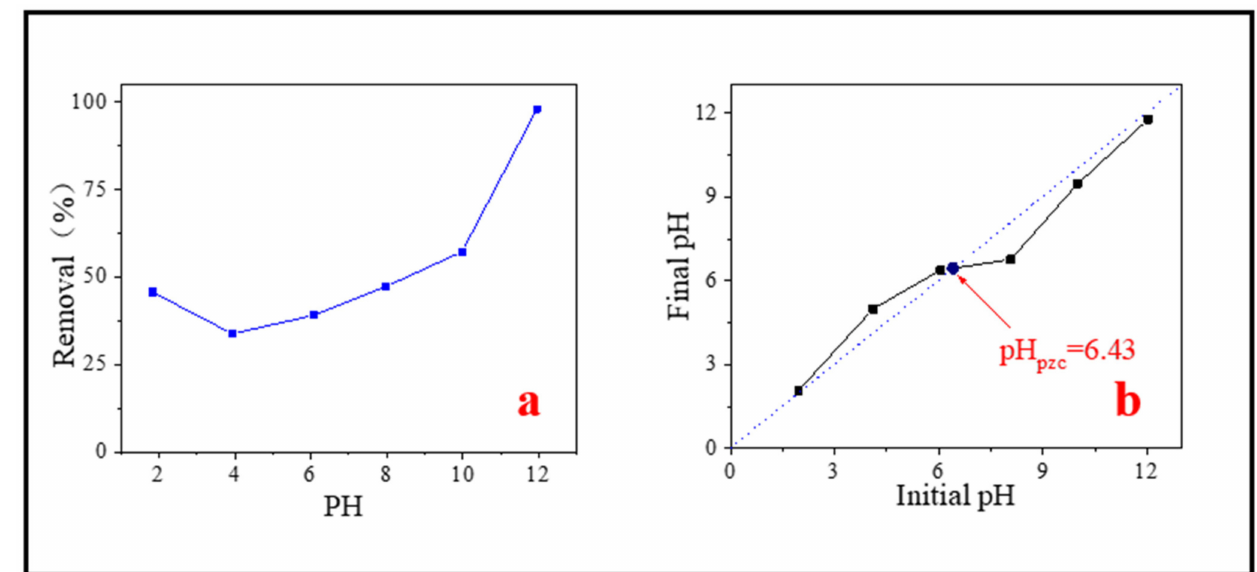
Figure 8. ( a ) Effect of initial solution pH on MB removal; ( b ) Determination of isoelectric